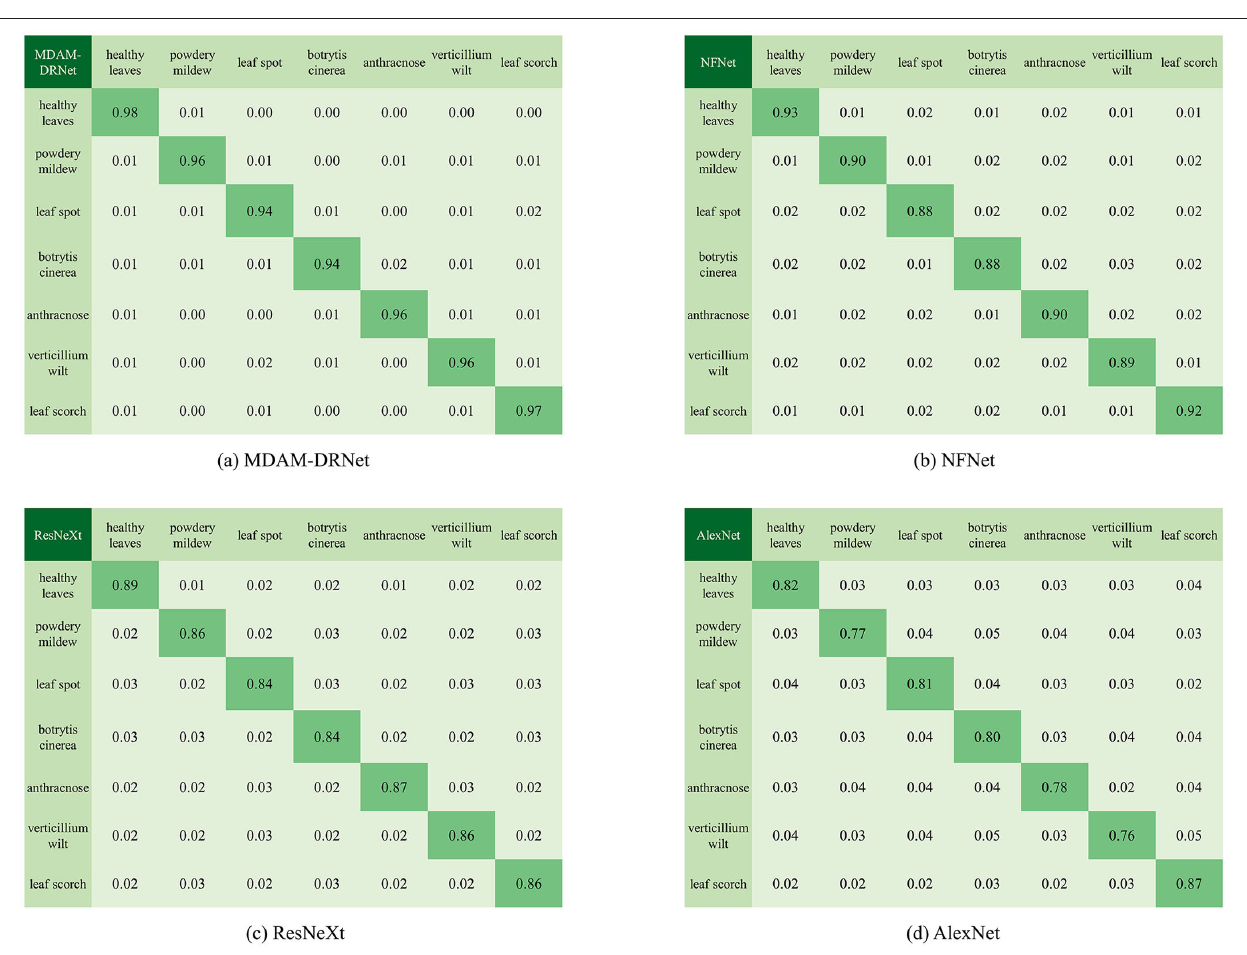
TABLE 10 | Category of three public data sets, number of training set pictures, and number of test set pictures.